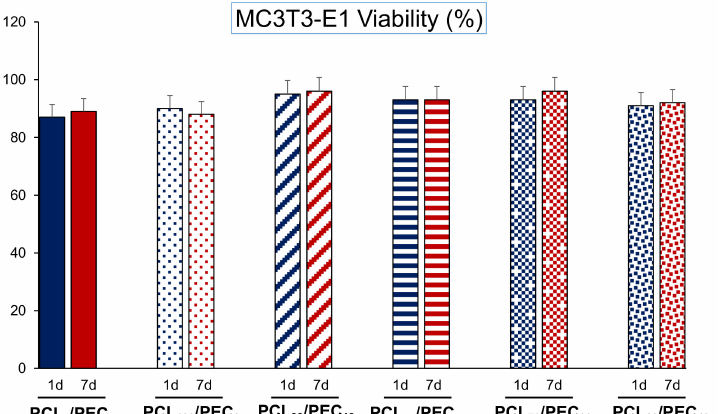
Figure 7. Cell viability of the MC3T3-E1 pre-osteoblasts cultured on PCL-PEC films during days 1 and